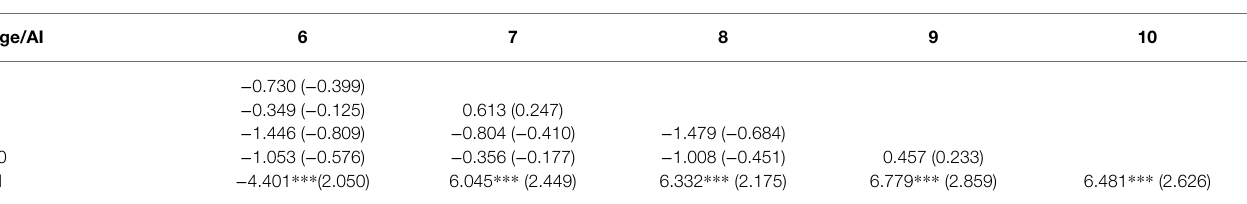
TABLE 6 | T-ratio for pairwise comparisons (contrast effects) between age groups/AIs on Aligned Rank data. All DFs 76. Age/AI 6